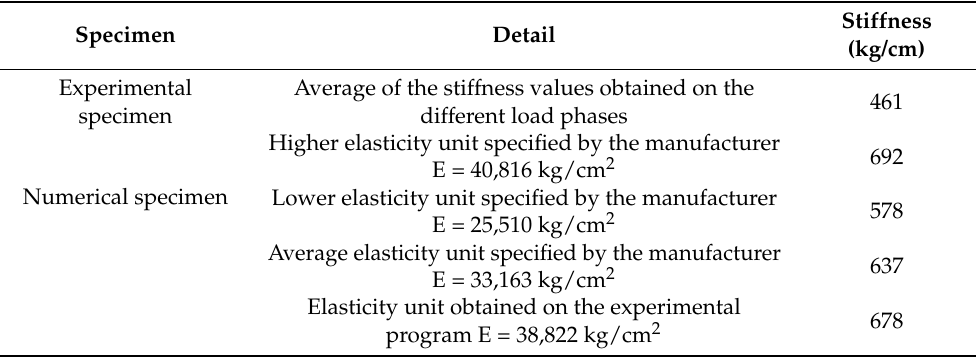
Table 6. Comparison of the stiffness obtained.